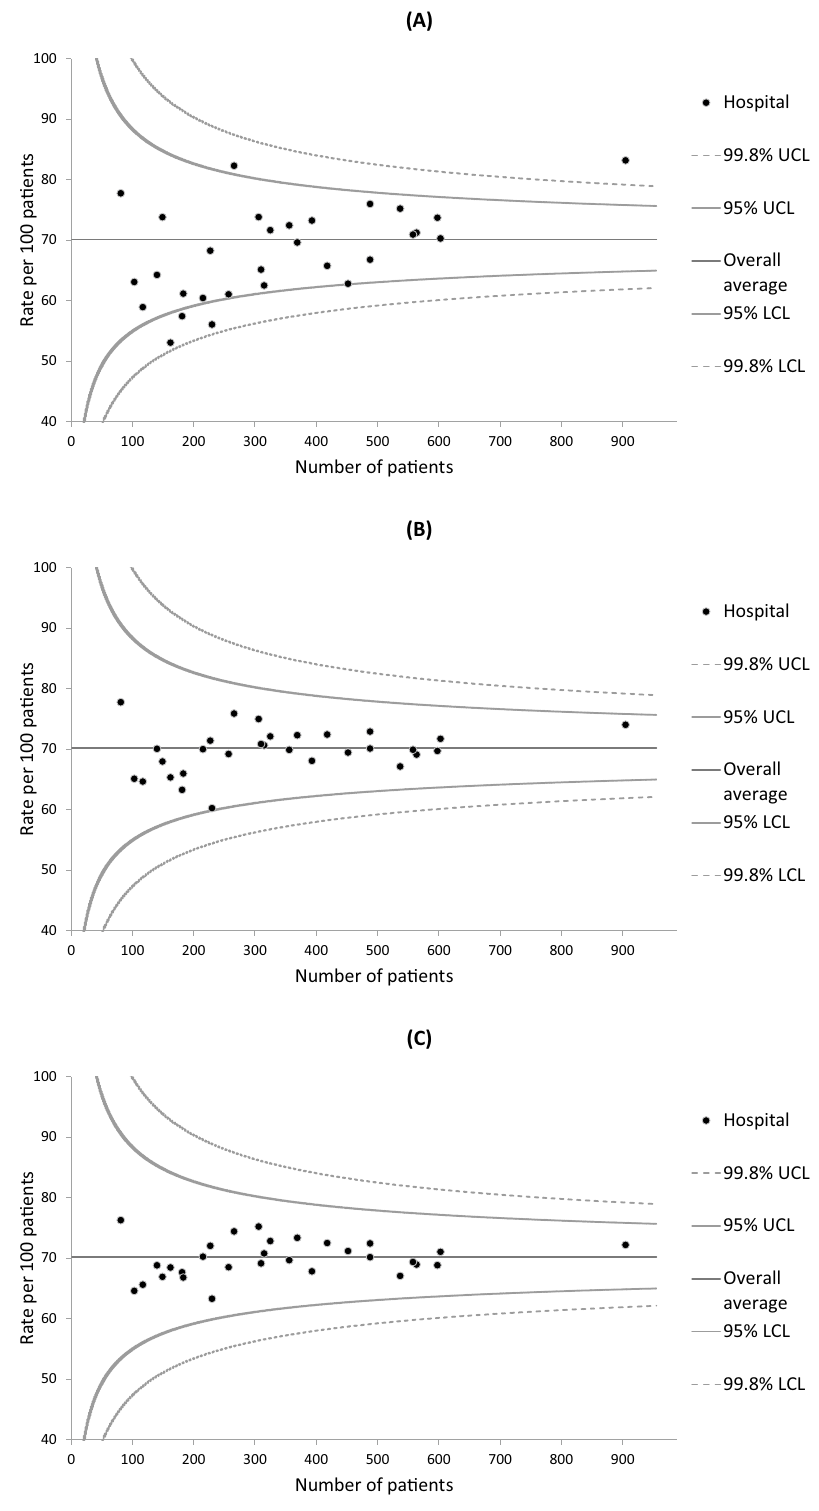
Figure 2. Funnel plots of 3-year survival and the number of gastric cancer patients in each hospital. ( A ) Unadjusted survival; ( B ) Partially adjusted survival that controlled for age, sex, and cancer stage; and ( C ) Fully adjusted survival that controlled for comorbidities, activities of daily living, type of admission, smoking status, and body mass index in addition to the variables in the partially adjusted model. LCL lower control limit, UCL upper control